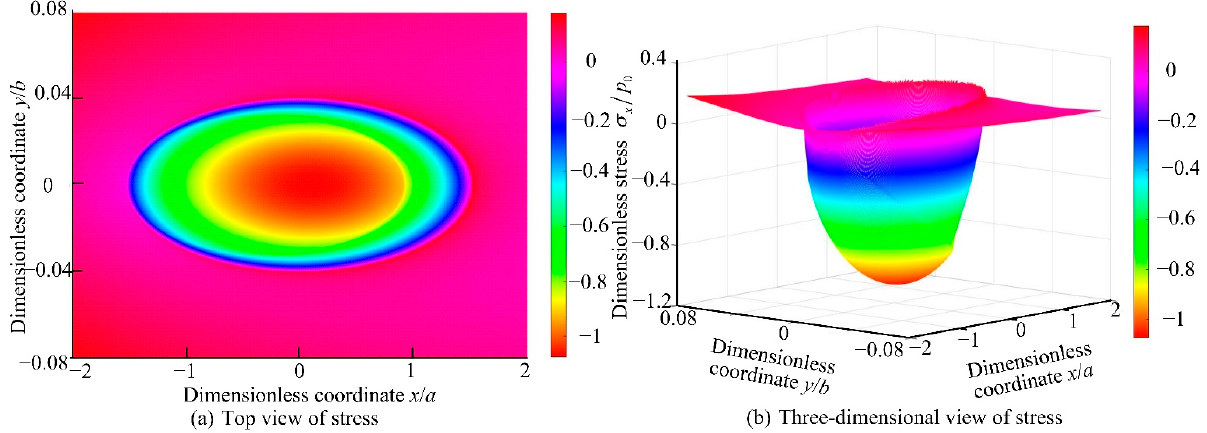
Figure 5. Distribution of dimensionless stress σ x / p 0 for k = 0.8 and µ = 0.15.